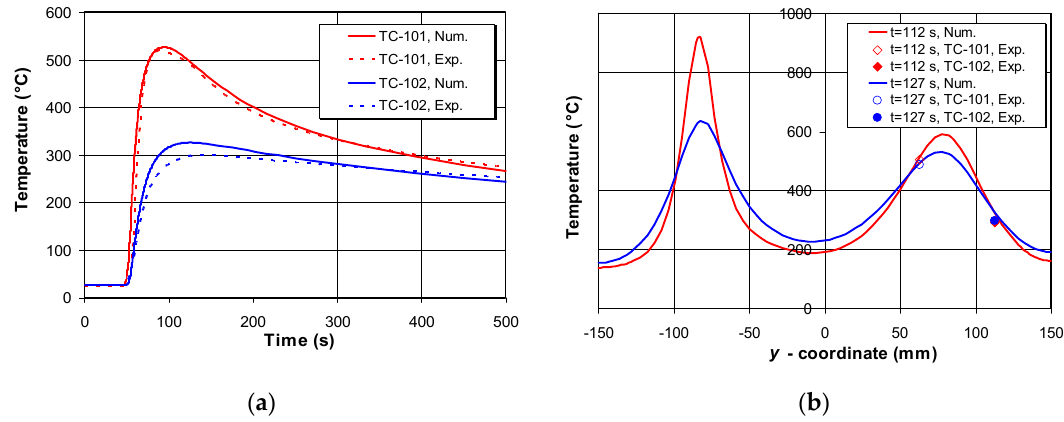
Figure 5. Thermal measurement results at nodes TC-101 and TC-102: ( a ) Temperature history curves; ( b ) Cooling process curves (Figure 1a, line A-B, ϕ = 90°).